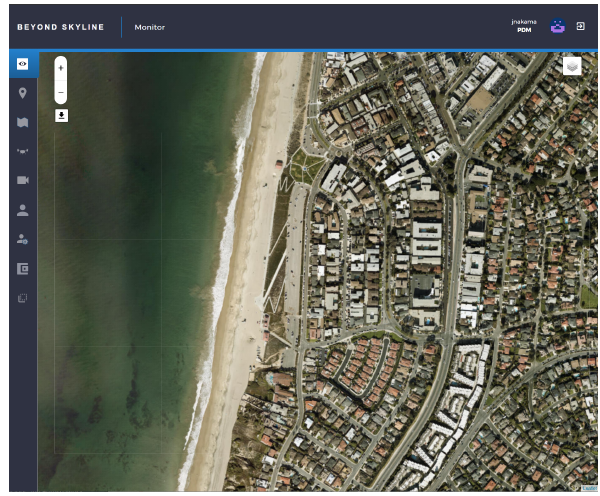
Figure 2. The Beyond Skyline Cloud Platform, including the satellite view of the map and the EasyPrint button in the top left corner.